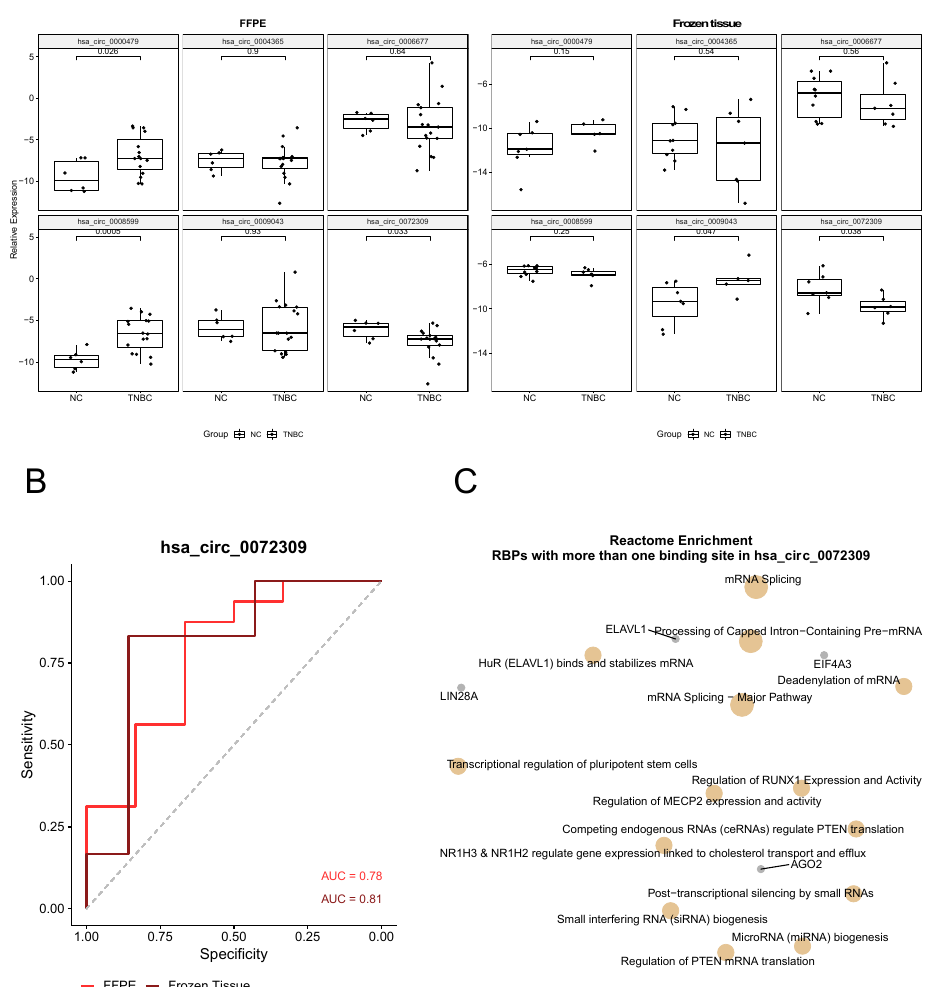
Figure 5. Hsa_circ_0072309 shows a promising potential as a biomarker of TNBC. ( A ) Validation of hsa_circ_0072309, circ_0004365, circ_0006677, circ_0008599, circ_0009043, and circ_0000479 in two new sample sets: FFPE and frozen tissue (left and right panels, respectively) of TNBC patients ( n = 6 and n = 10, respectively) and patients without cancer ( n = 17 and n = 7, respectively. NC = non-cancer). p -values shown are from a Student’s t -test. Expression levels were calculated using the Comparative Ct method and ACTB and PUM1 were used as reference genes for frozen and ffpe tissues, respectively; ( B ) ROC curves of hsa_circ_0072309 in FFPE (bright red) and frozen tissue (dark red) samples showing an Area Under the Curve (AUC) with at least 0.78, indicating that this circRNA has good ability in discriminating TNBC from non-cancer patients; ( C ) Reactome enrichment of the RBPs with more than one binding site in hsa_circ_0072309 showing that this circRNA is acting in many cancer-related pathways, such as “Regulation of PTEN translation” and “Regulation of RUNX1 Expression and